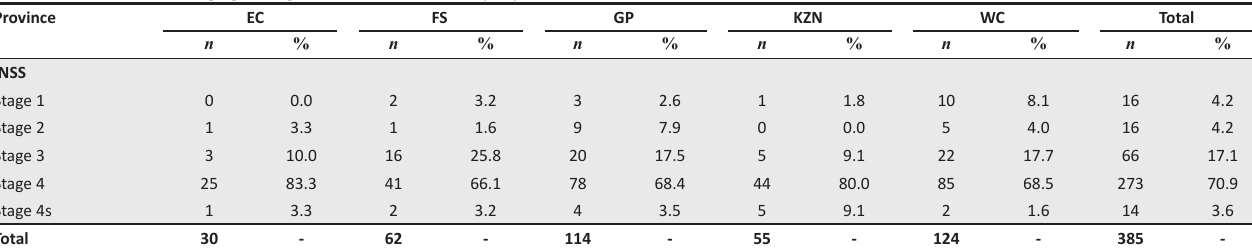
TABLE 3: Neuroblastoma staging at diagnosis from 2000 to 2014 per province in South Africa. Province